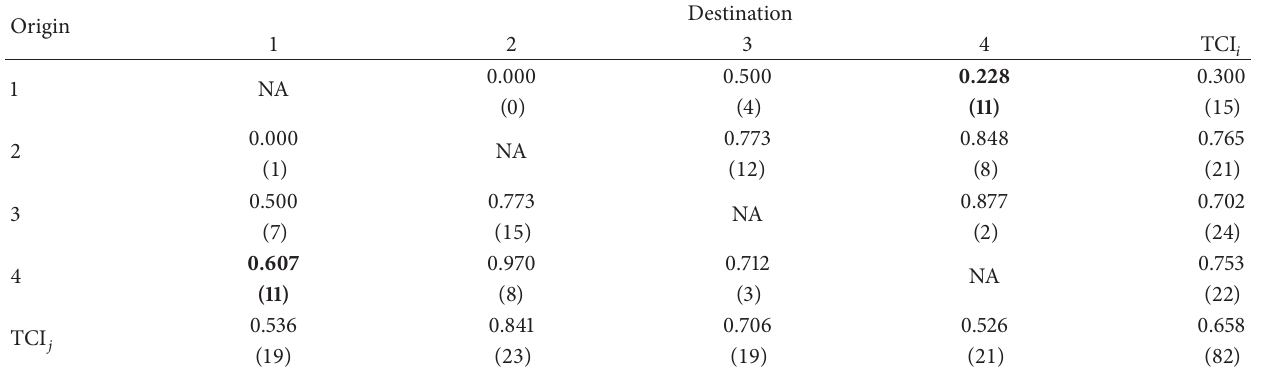
Table 4: TCI and travel demand (in brackets).